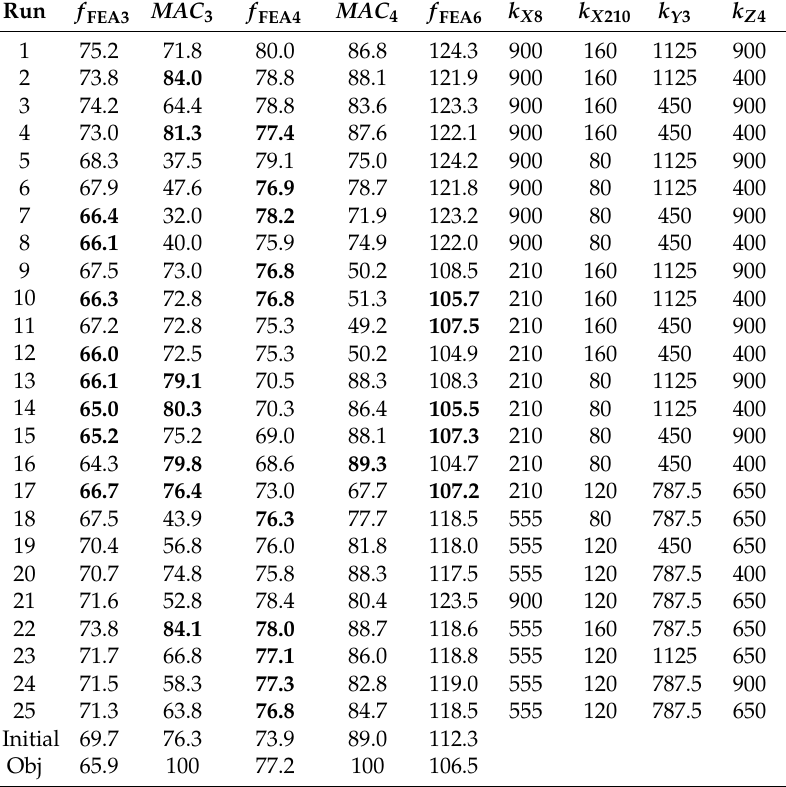
Table 12. Variables and responses in central composite design